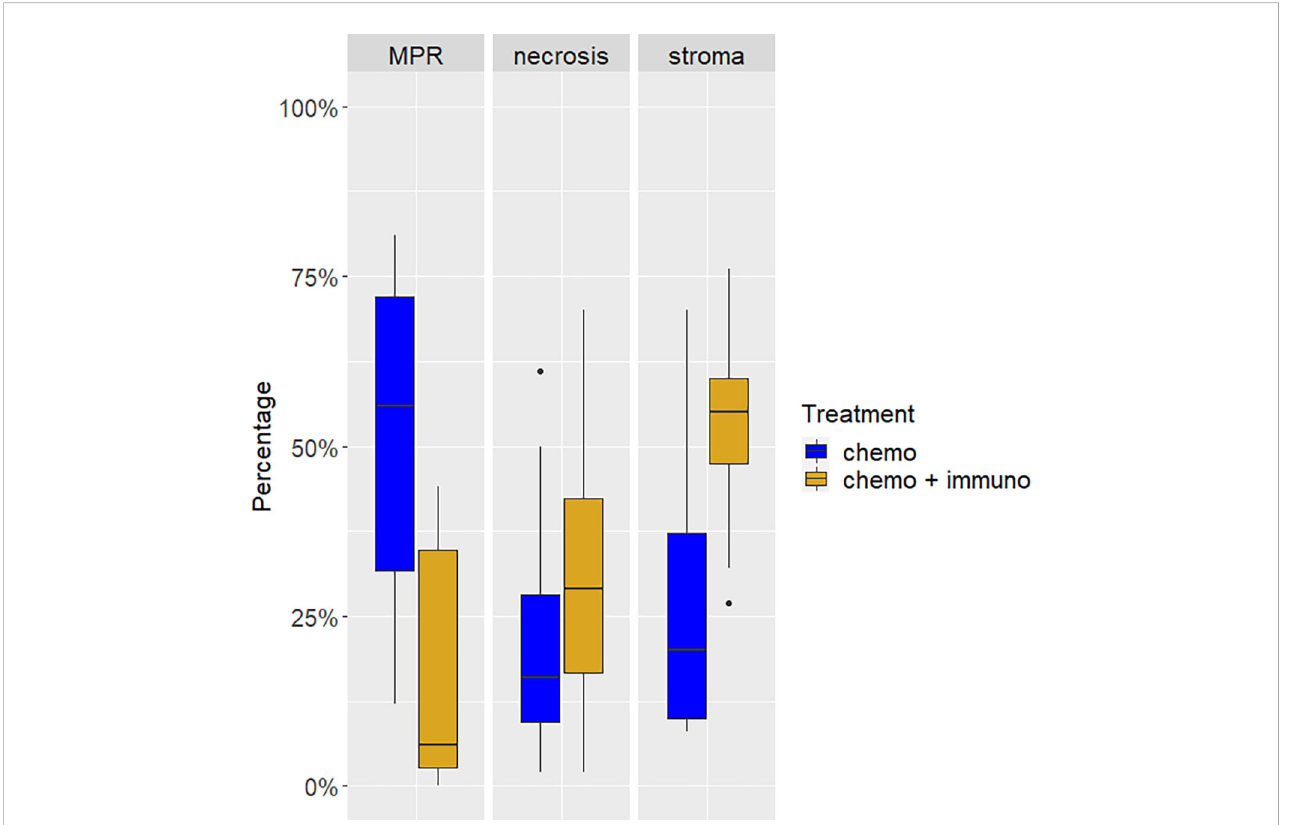
FIGURE 1 Tumor composition after neoadjuvant treatment with chemo- or chemo-immunotherapy. The proportion of viable tumor cells (major pathological response, MPR) was lower in tumors from patients of the chemo-immunotherapy cohort. These cases showed also a higher proportion of necrosis and